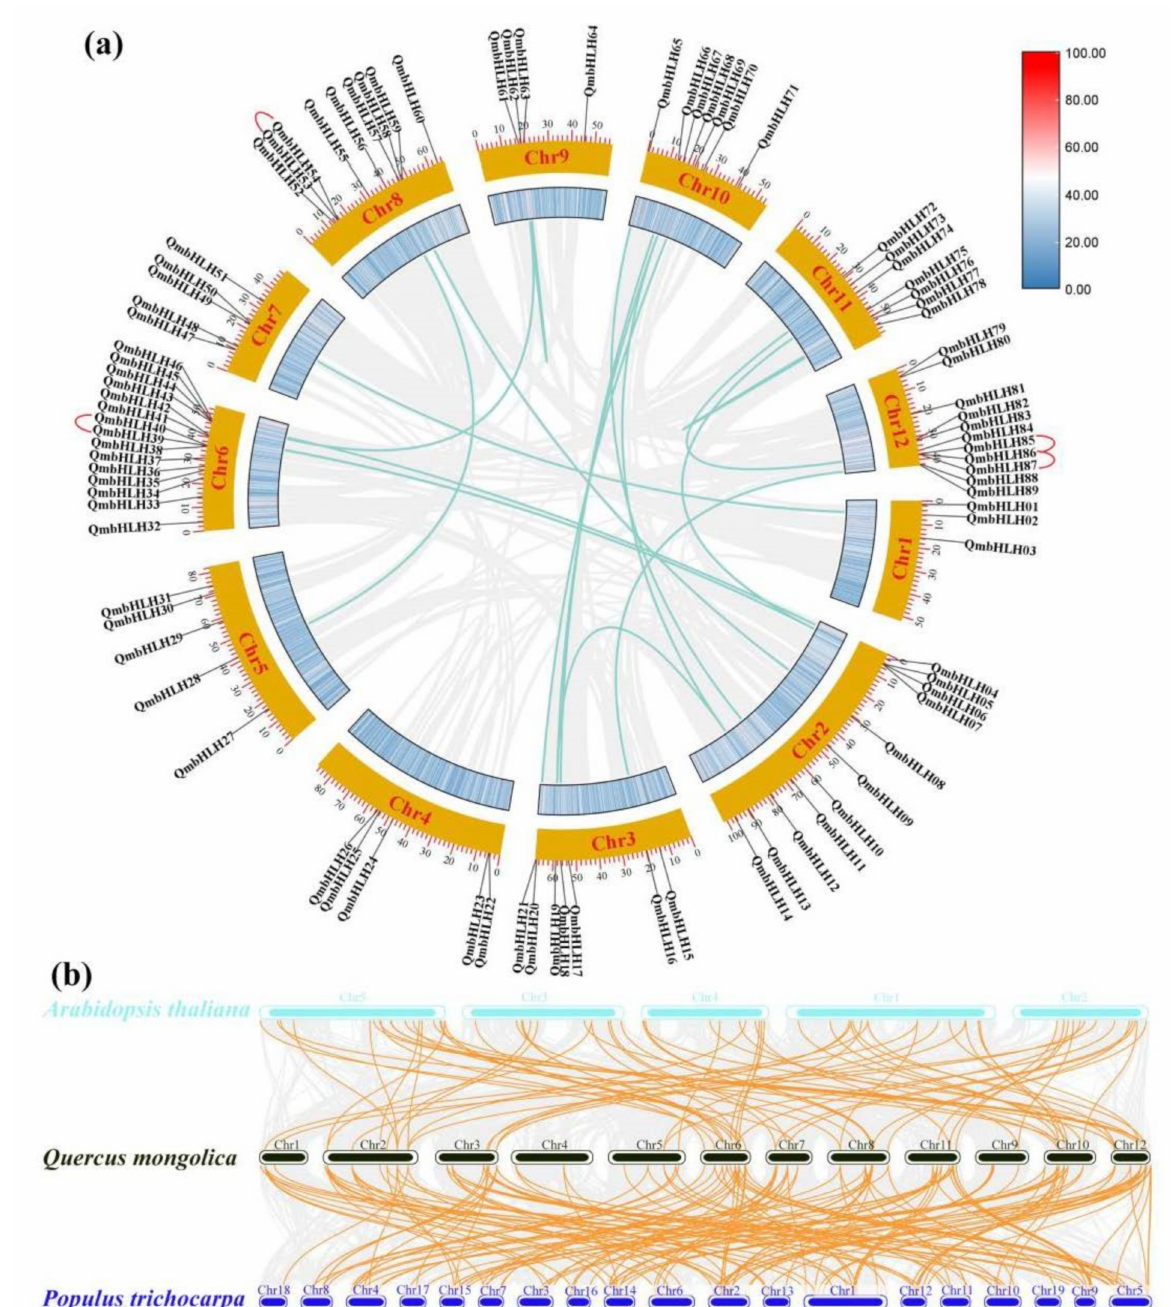
Figure 4. ( a ) Interchromosomal correlations and chromosomal distribution of the QmbHLH genes. Tandem duplicated genes are indicated with a red line. Gray lines represent all the synteny blocks in the genome of Q. mongolica , while turquoise lines indicate the segmentally duplicated QmbHLH gene pairs. Heat maps represent the density of genes on chromosomes. The yellow circles represent chromosomes. The number of chromosomes is shown in the middle of each chromosome. The scale on the circle is in terms of MegaBase (Mb) and represents chromosome length. ( b ) The bHLH gene synteny analysis of P. trichocarpa , A. thaliana , and Q. mongolica . In the background, the gray lines represent the collinear blocks between the genomes of P. trichocarpa , A. thaliana , and Q. mongolica . The collinear bHLH gene pairs are highlighted with orange lines. The chromosome numbers are on the left side of each